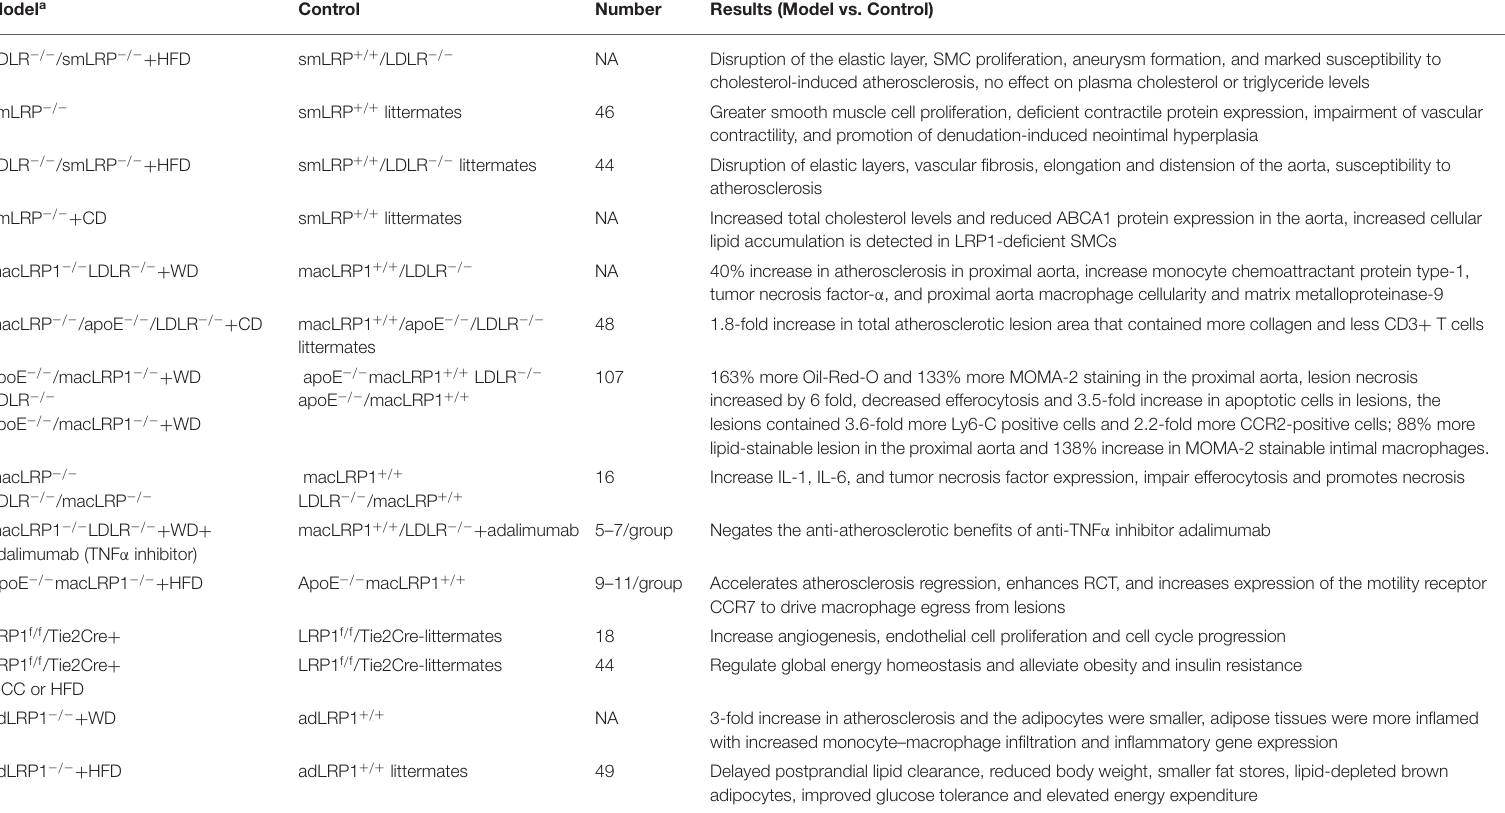
TABLE 3 | Animal experiments about effects of deletion of LRP1 on atherosclerosis lesions. Model a Control Number Results (Model vs.